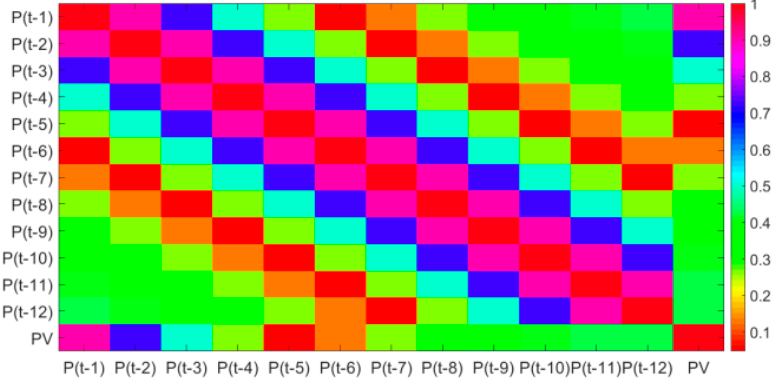
Figure 3. The Pearson coefficient relationship between the historical photovoltaic power and the next photovoltaic power.